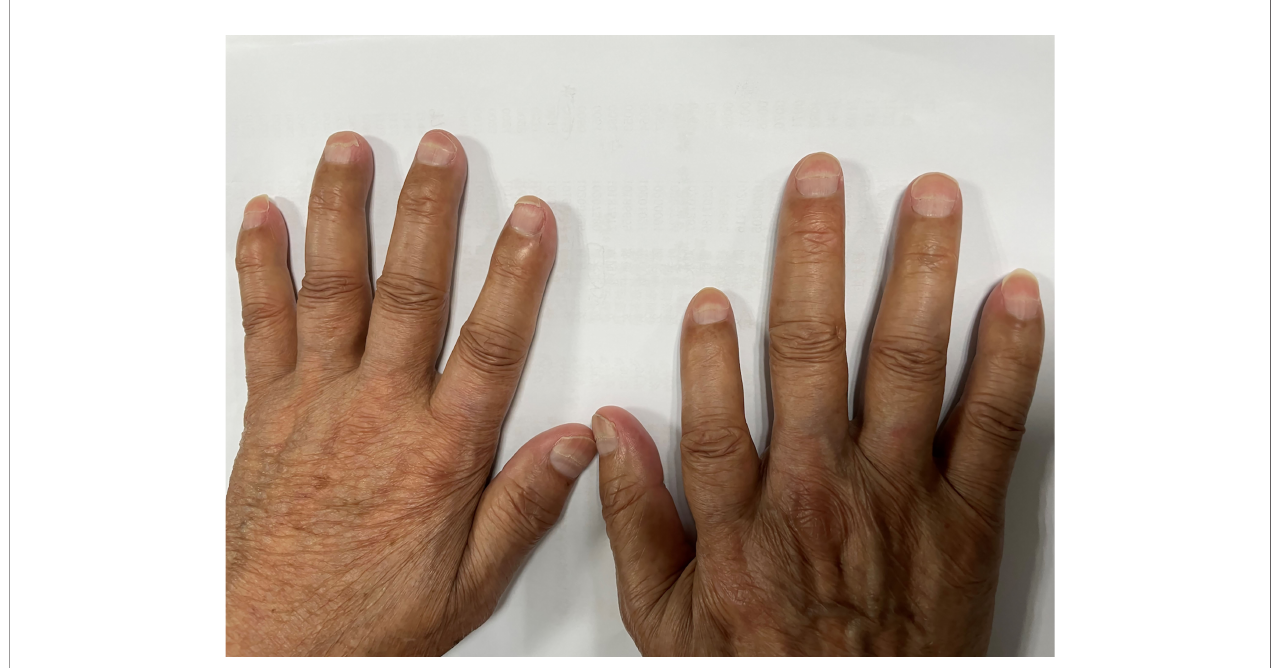
FIGURE 4 | Broken nails on the patient ’ s hands after combined